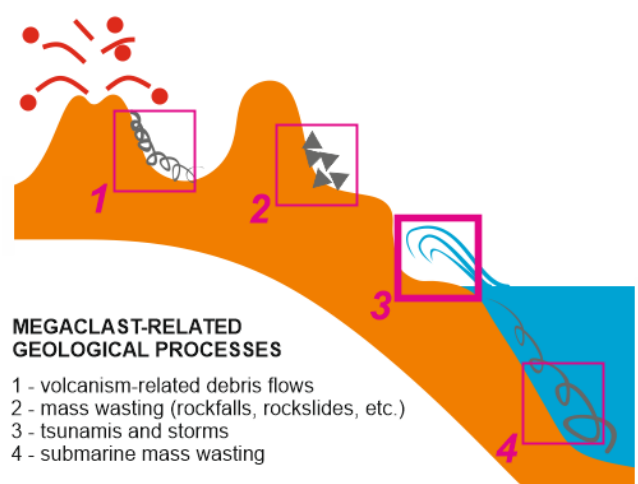
Figure 5. The main megaclast-related geological processes studied during 2000–2017; the bold frame indicates the most intensively studied processes (created by the authors).